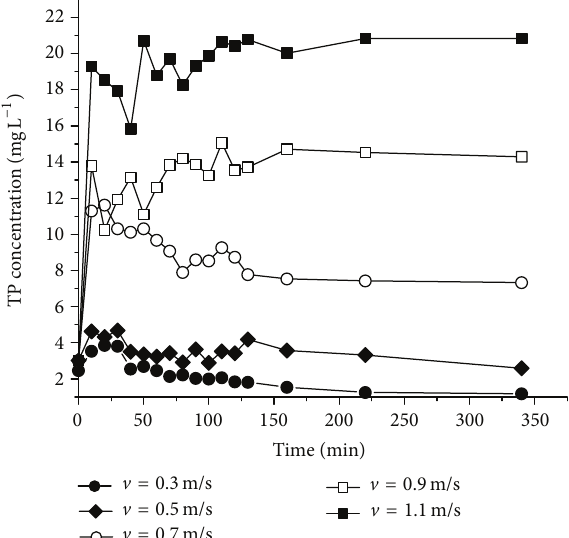
Figure 7: Concentration changes of TP in the flow rate effect experiments.